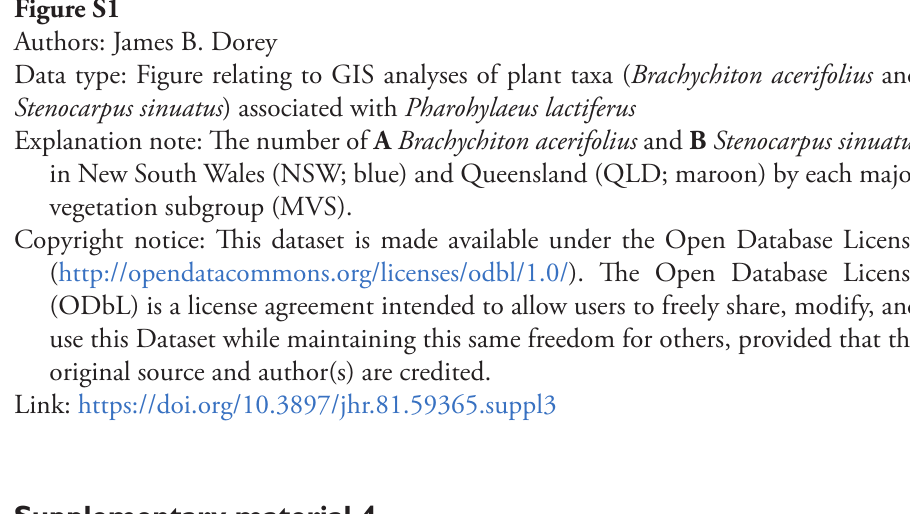
Data type: Figure relating to GIS analyses of plant taxa ( Brachychiton acerifolius and Stenocarpus sinuatus ) associated with Pharohylaeus lactiferus